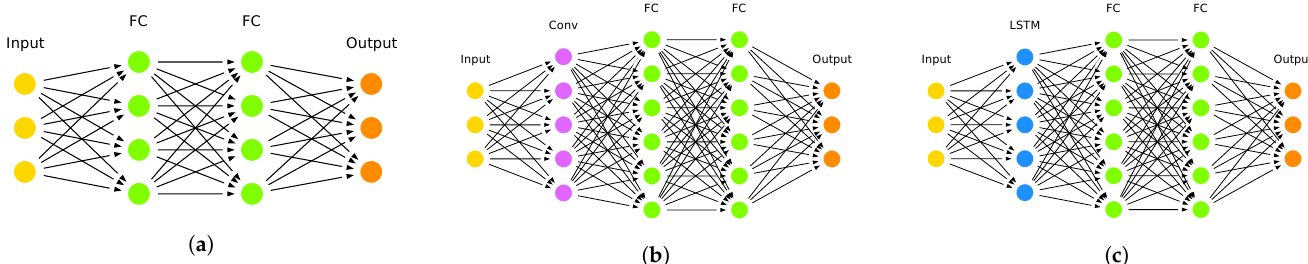
Figure 3. Conceptual presentations of the network architectures used in this research: ( a ) multilayer perceptron; ( b ) 1D- convolutional network; ( c ) LSTM